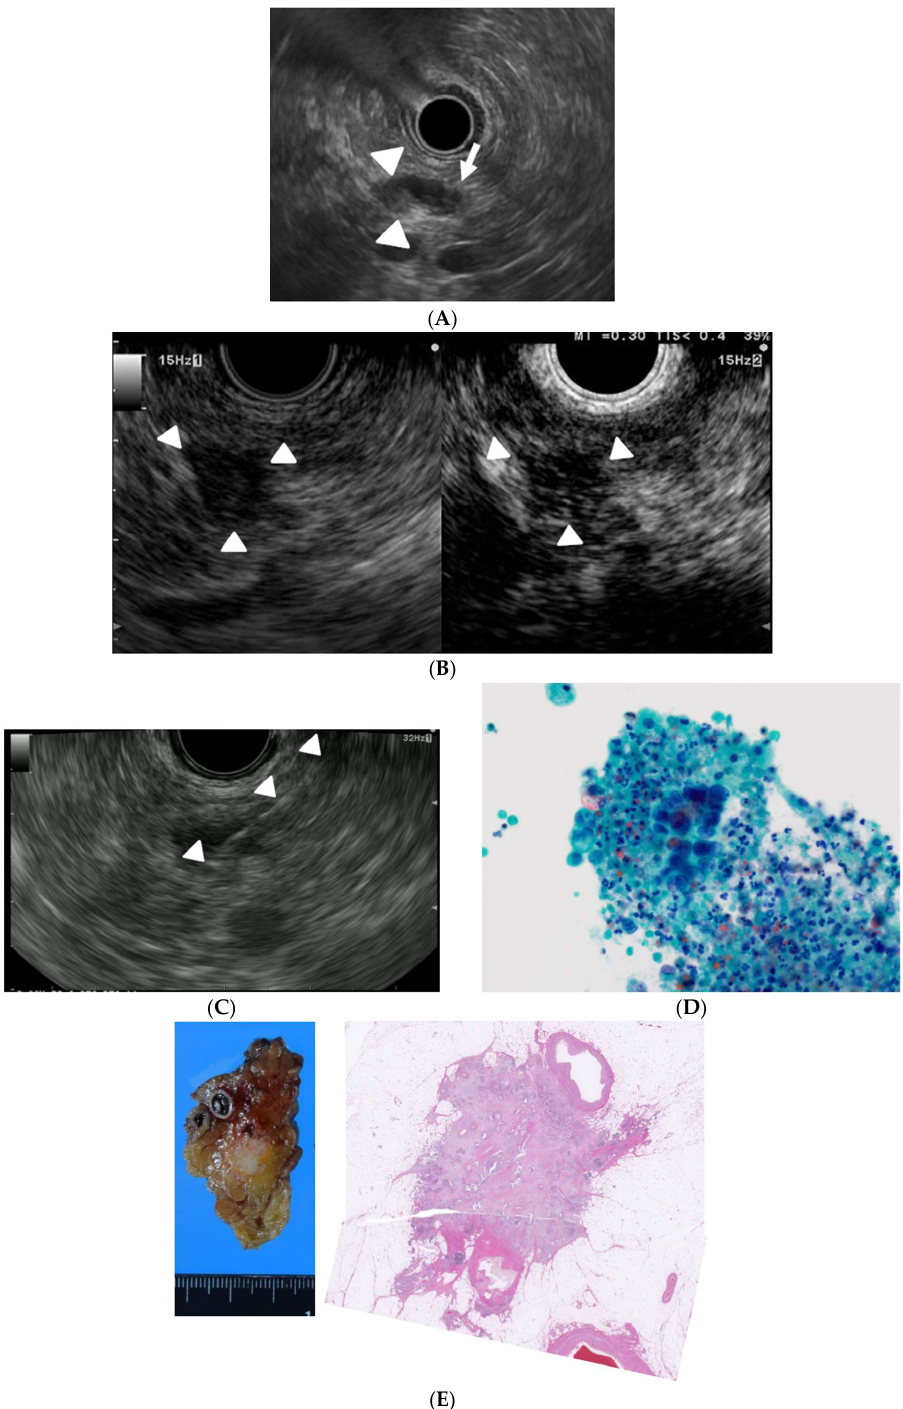
Figure 1. A case of small pancreatic cancer. ( A ) Endoscopic ultrasound (EUS) detection of a hypoechoic lesion (9 mm, pancreatic body, arrowhead) with distal dilation of the pancreatic duct (arrow); ( B ) Conventional EUS showing a hypoechoic lesion (arrowhead) at the pancreas body (left) and contrast-enhanced EUS (CE-EUS) showing the lesion has a lower intensity than that of the surrounding tissue (right); ( C ) EUS-guided fine-needle aspiration (EUS-FNA). The needle targeted the lesion through the stomach (arrowhead); ( D ) Cytological examination of the aspirated material suggested the presence of an adenocarcinoma (Papanicolaou × 1000); ( E ) The surgically removed lesion (left) and histological findings revealed a final diagnosis of pancreatic cancer